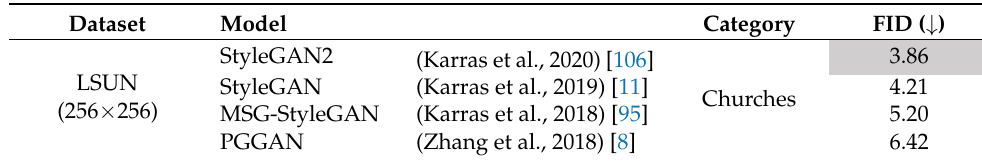
Table 12. The FID of different models trained on LSUN churches dataset. The lower the FID value, the better the performance.